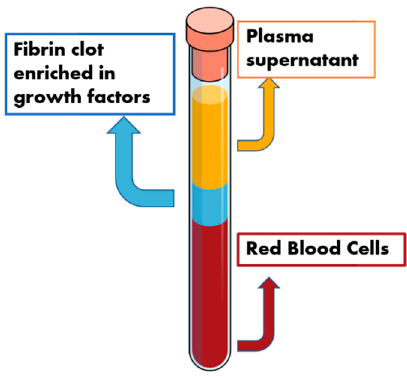
Figure 3. Schematic representation of the autologous platelets concentrates. Red blood cell bodies can be found on the bottom of the centrifugation product. The middle portion is composed of the “scaffold” portion (fibrin fibres) and the induction molecules (growth factors). The upper portion is represented by the supernatant plasma proteins.